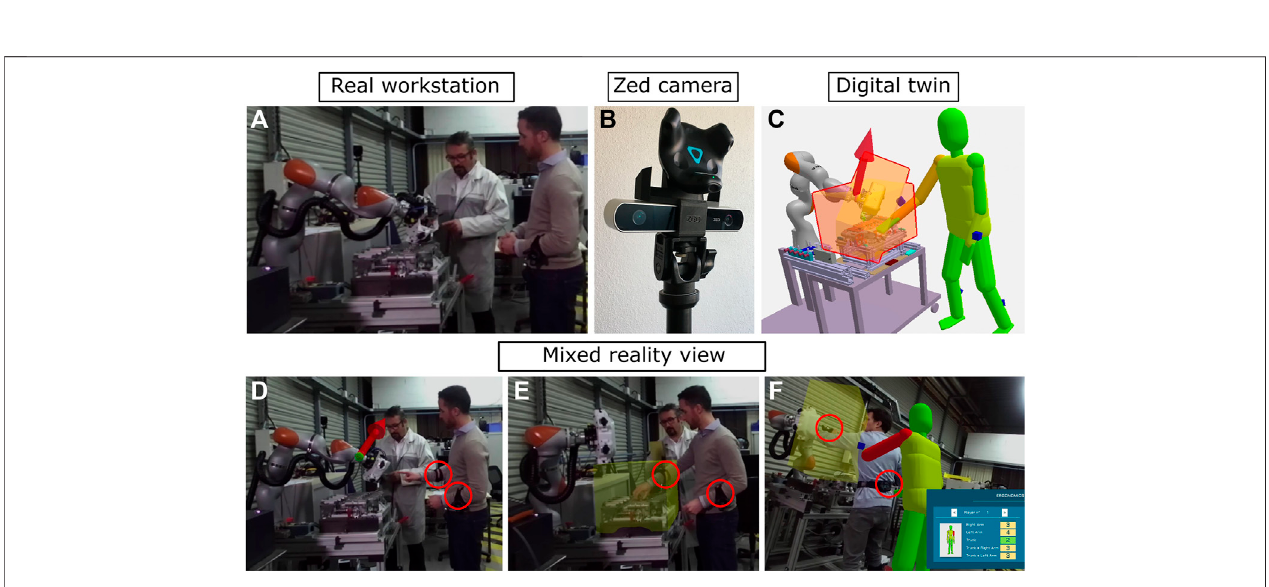
FIGURE 9 | An industrial use case involving one Kuka iiwa robot. The real workstation (A) and the digital twin (C) are superimposed thanks to a Zed camera (B) to show robot velocities (D) , safety areas (E) and ergonomics scores (F) . Motion capture sensors (HTC Vive Trackers) are circled in red.